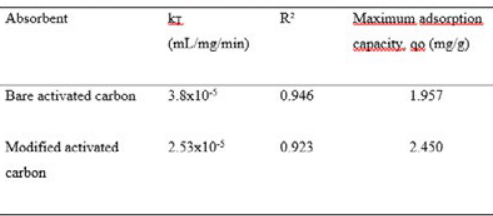
Figure 4: Linear plot of Thomas model for ammonia absorption using (a) bare activated carbon (b) modified activated carbon Linear plot of ln [(C0/Ct)-1] against treatment time (t) was used to determine the value of KT and qo based on the intercept and slope of the plot (Table 2). Based on the Thomas model, the value of qo bare activated carbon and modified activated carbon are 1,957 mg/g and 2.450 mg/g, respectively. This implies that the modified activated carbon has a higher qo and more effective for removing ammonia compared to bare activated carbon.